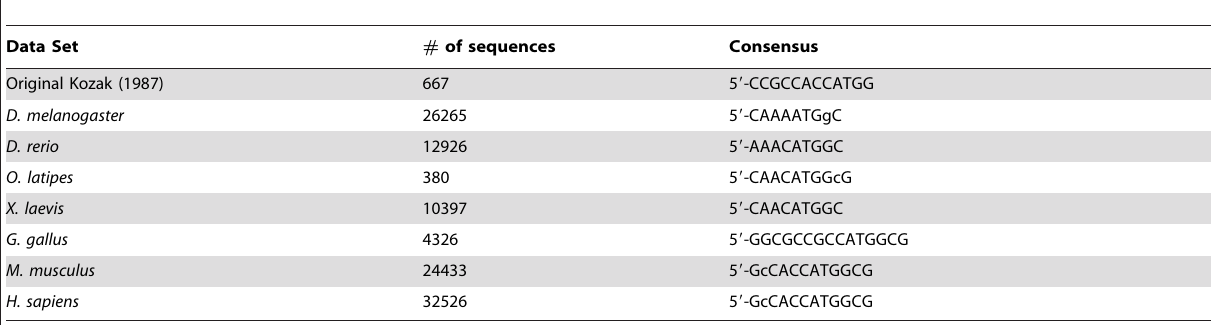
Table 2. Bioinformatic data sets and consensus Kozak